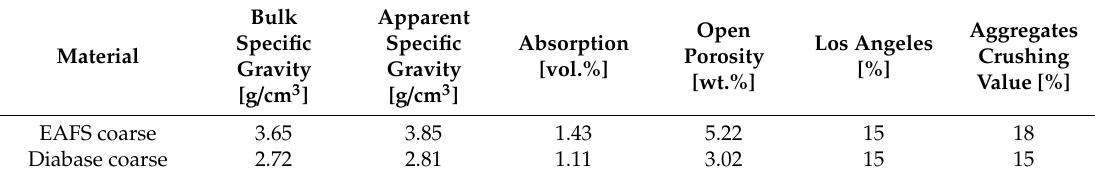
Table 1. Main properties of the coarse aggregates used in the self-compacting concrete (SCC).